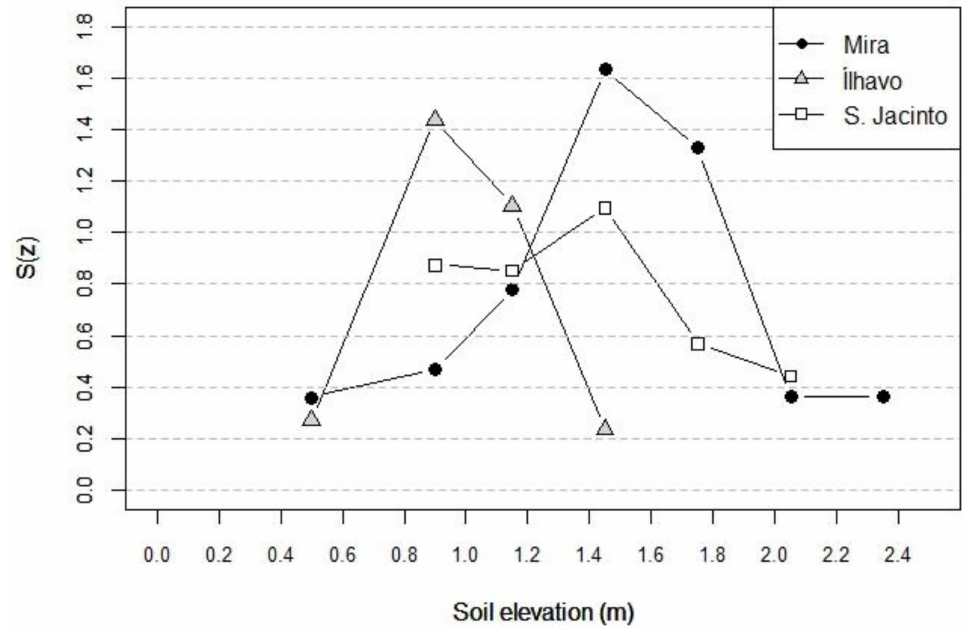
Figure 5. Elevation-dependent Shannon’s entropy, S ( z ), for the studied salt